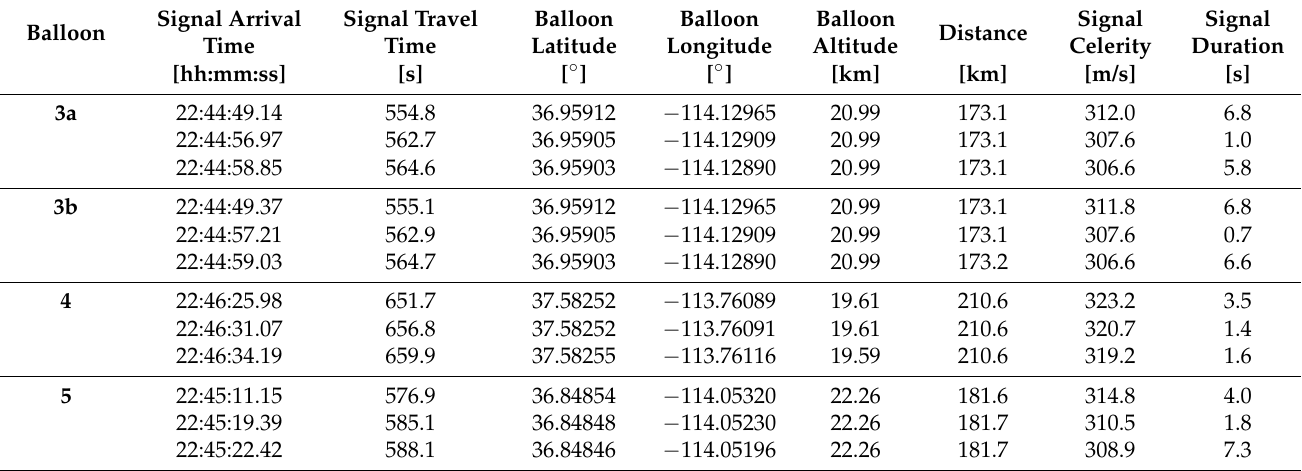
Table 1. List of the signal parameters associated with the three phases detected by each sensor. The first column lists the balloon numbers. 3a and 3b are the top and bottom sensors, respectively, attached to Balloon 3. Starting with the second column, the signal parameters are: arrival time, balloon locations at the onset of each arrival (latitude, longitude, altitude), source-receiver distance along great circle, signal celerity, and signal